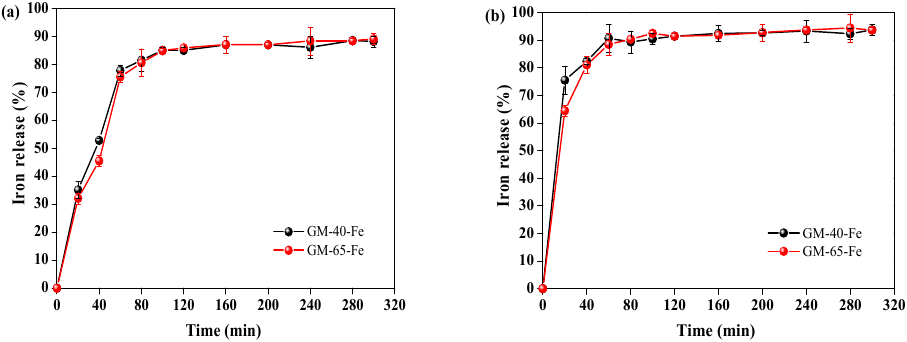
Figure 7. The iron release of galactomannan–iron(III) complexes in the artificial gastric juice at pH 2.0 ( a ) and artificial intestinal juice at pH 8.0 ( b ).